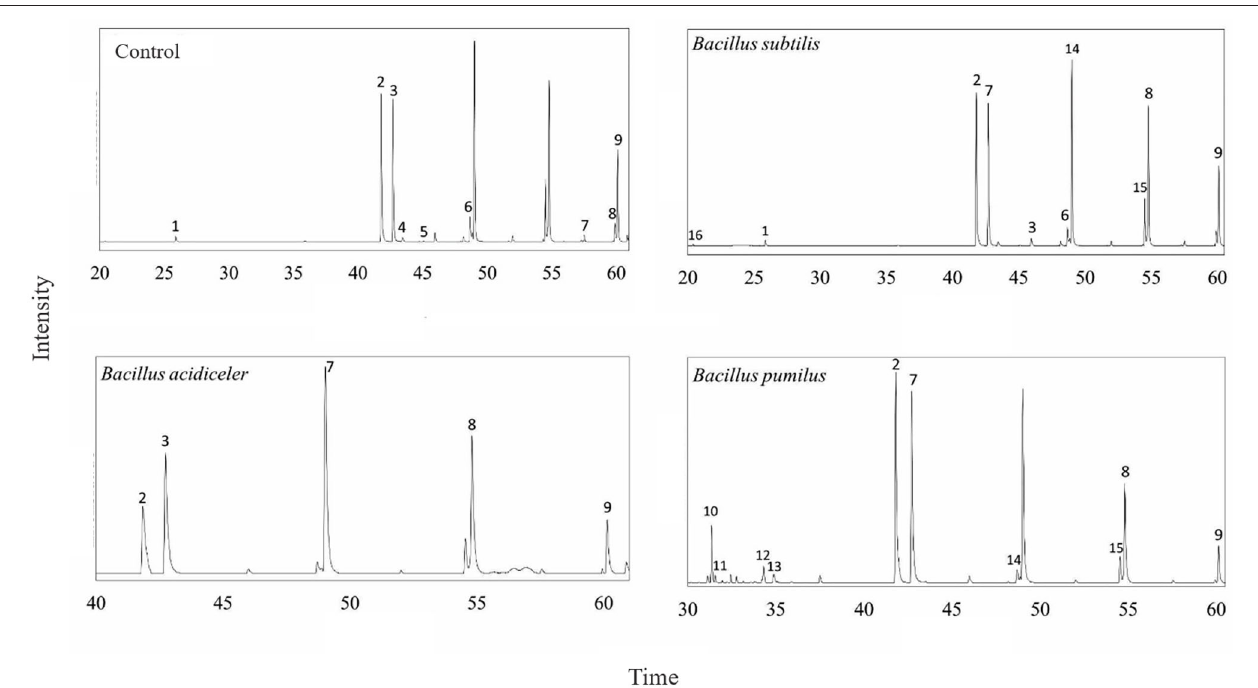
FIGURE 2 | Chromatography of essential oils of rose cv. Black Prince relating the retention time and intensity of each component, according to each growth-promoting bacteria, being: (1) Myrtanol, (2) Cetyl alcohol, (3) Eicosane, (4) Hexadecanoic acid, (5) Hexenol, (6) Pentadecanol, (7) Docosane, (8) Tetracosane, (9) Pentacosane, (10) Caryophyllene, (11) α -Selinene, (12) Limonene, (13) α -Farsene, (14) Heneicosane, (15) Heptadecyl alcohol, (16) Theaspirane.